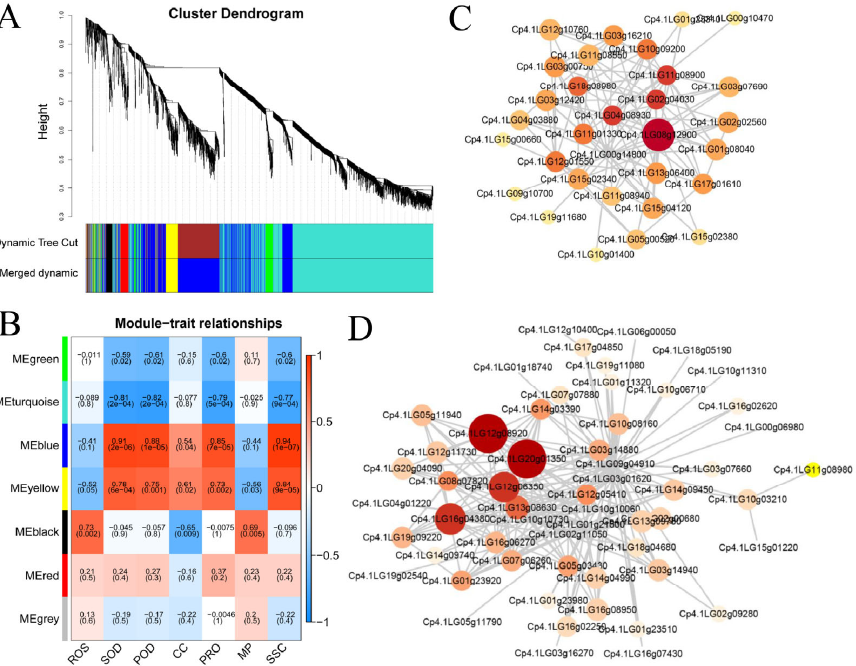
Figure 5. Weighted gene coexpression network analysis of DEGs in zucchini leaves. ( A ) Hierarchical clustering tree and heatmap of genes were constructed by correlation coefficients between genes. Different branches of the clustering tree represent different gene modules, and different colors represent different modules. ( B ) Correlation between the physio ‐ biochemical indexes and each module. Module names are displayed on the Y ‐ axis, and the physio ‐ biochemical indexes are displayed on the X ‐ axis. The depth of the color indicates the degree of correlation (red, positive correlation; blue, negative correlation). CC, chlorophyll content. PRO, proline. MP, mem ‐ brane ‐ lipid peroxidation damage. SSC, soluble sugar contents. ( C , D ) The circle diagram shows the predicted regulatory network for the yellow module ( C ) and blue module ( D ). In contrast, the Meturquoise module and the Megreen module showed negative correlations with SOD, POD, proline, and soluble sugars. The Meblack module had a high positive correlation with ROS, while it showed a moderate negative correlation with chlorophyll content, indicating that genes in this module play a major role in modulating ROS levels. The poor correlation of the Mered module and the Megray module with these substances suggests that the DEGs in the two modules might not be involved in the regulation of these substances. Based on the above analysis, a co ‐ expression network was further constructed for the Meblue and Meyellow modules (Figure 5C and 5D). Based on the coexpression network, Cp4.1LG12g08920 ( be ‐ ta ‐ fructofuranosidase ), Cp4.1LG20g01350 , Cp4.1LG08g12900 , Cp4.1LG16g04380 , Cp4.1LG12g06350 , Cp4.1LG04g08930 ( chitotriosidase ‐ 1 ‐ like ), Cp4.1LG02g04030, and Cp4.1LG11g08900 ( F ‐ box protein PP2 ‐ B15 ‐ like ) genes were screened as potential Hub genes. The beta ‐ fructofuranosidase, also called invertase, catalyzes the degradation of sucrose into fructose and glucose and participates in osmotic regulation and the accumulation of sugar in cells [33]; thus, increased expression of the be ‐ ta ‐ fructofuranosidase gene improves the osmotic adjustment ability of leaves under LT stress. These results collectively indicated that these genes played a key role in the response to LT stress. Future studies will elucidate the function of these genes and their roles in modulating humic acid ‐ mediated LT tolerance in zucchini.